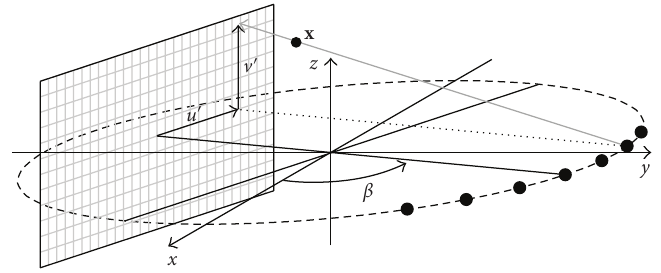
Figure 6: Scheme of the the rebinned fan-parallel beam